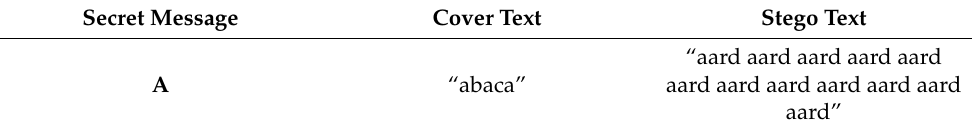
Table 2. Example of Random and Statical Generation (Data from